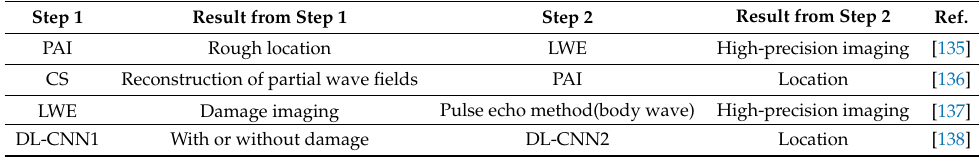
Table 5. Multiple combinations of laser ultrasonic